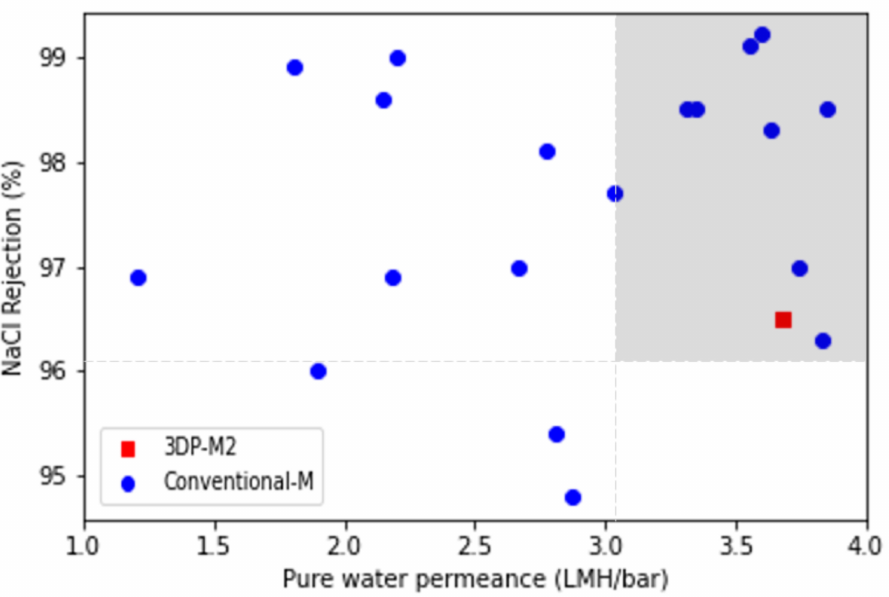
Figure 8. Desalination performance of printed polyamide vs. conventional membranes [46,47,57–70]. NaCl salt rejection and pure water